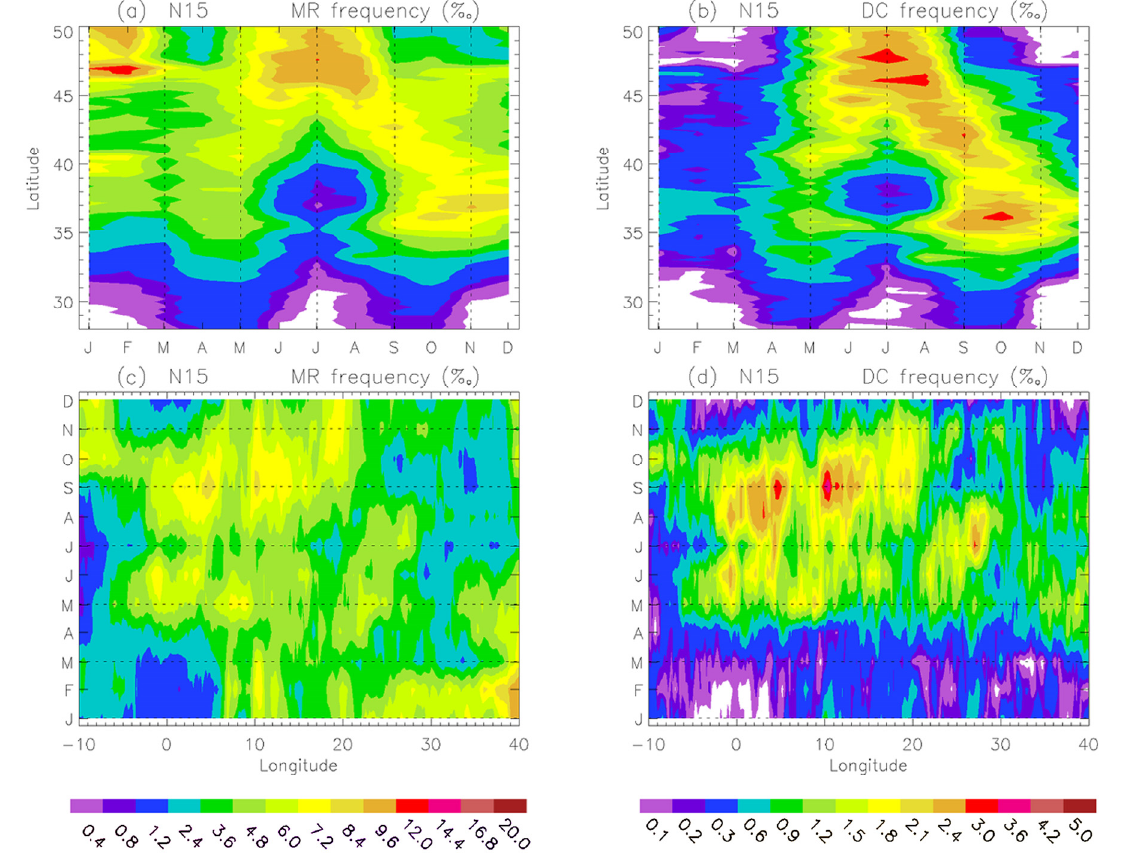
Figure 7. Latitude time sections ( a , b ) and time longitude ( c , d ) of MR (left column) and DC (right column) frequencies over the Mediterranean region based on NOAA-15 observations,